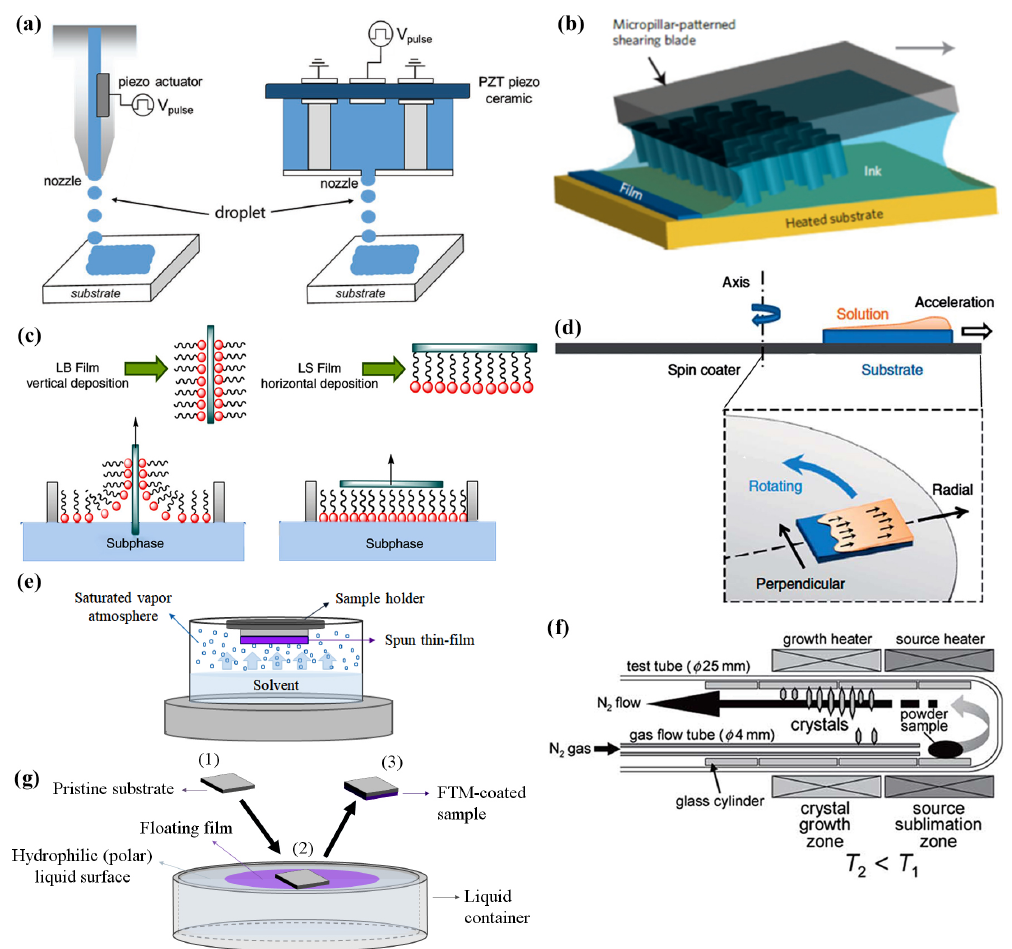
Figure 6. Illustration of currently used and innovative techniques for thin-film deposition of organic transistors as gas sensors: ( a ) Ink-jet printing. Reprinted from [111], with permission, from WILEY-VCH Verlag GmbH and Co. KGaA, Weinheim, ©2019. ( b ) Solution shearing. Reprinted by permission from Springer Nature Customer Service Centre GmbH: Nature, Nature Materials [114], ©2013. ( c ) Langmuir-based monolayers. Reprinted from [115], copyright 2017, with permission from Elsevier. ( d ) Off-center spin coating. Reprinted by permission from Springer Nature Customer Service Centre GmbH: Nature, Nature Communications [116], ©2014. ( e ) Solvent vapor annealing; ( f ) Physical vapor transport. Reprinted from [117], copyright 2008, with permission from Elsevier. ( g ) Floating film transfer